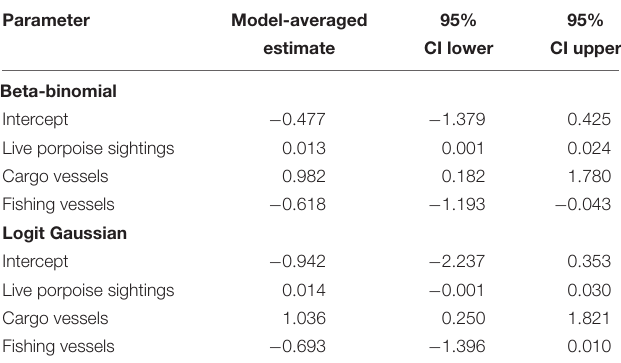
TABLE 2 | Beta-binomial and logit Gaussian model-averaged parameter estimates for Yangtze-wide analysis.